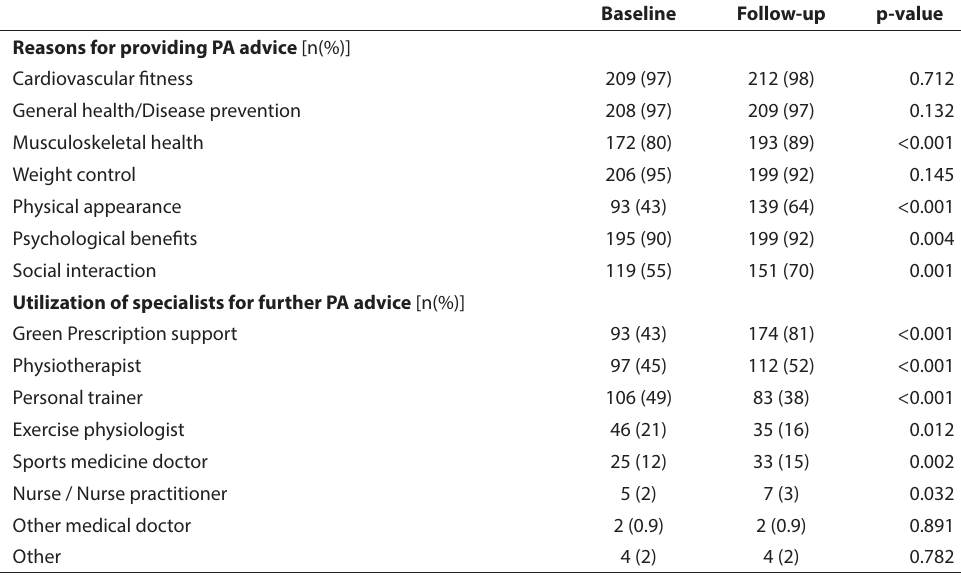
TABLE 4 The effects of the intervention on the reasons for providing PA advice in future and utilization of specialists for further